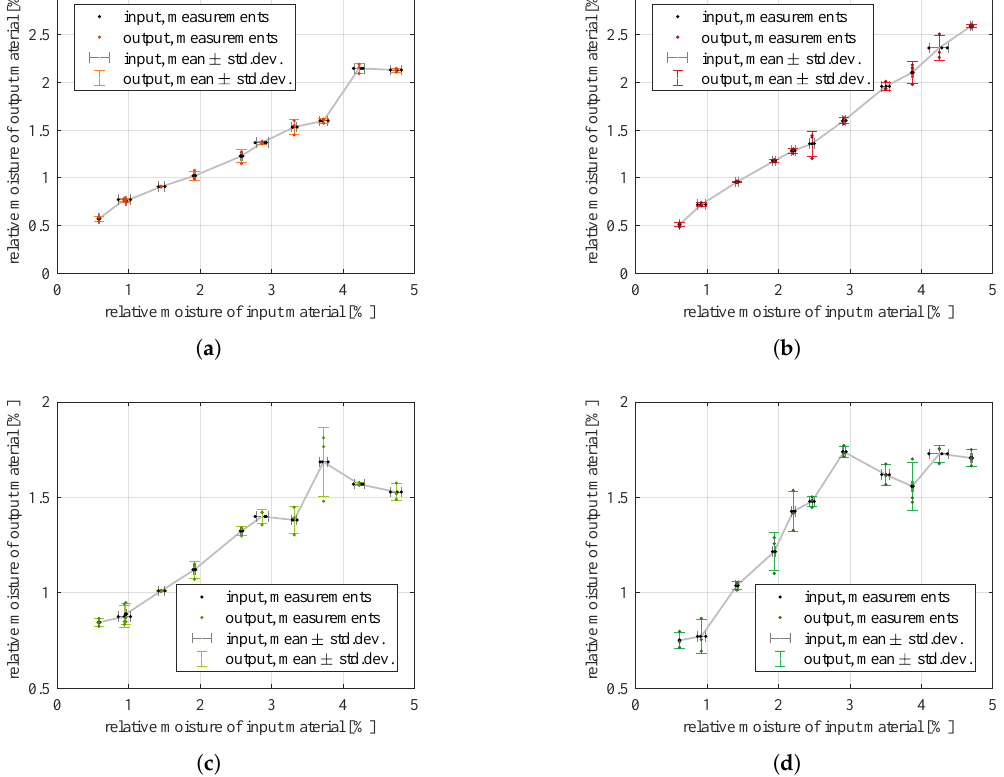
Figure 7. Measured moisture of both classification products related to moisture of input material, separately for different throughputs of the screw feeder: ( a ) lower product, 50% of nominal throughput; ( b ) lower product, 100% of nominal throughput; ( c ) upper product, 50% of nominal throughput; ( d ) upper product, 100% of nominal throughput. Points indicate three measurement attempts for each quantity in each experiment, error bars extend to ± 1 × sample standard deviation of the three measurements, cross-sections of horizontal and vertical error bars mark the averages of the three measurements. The fitted lines are plotted in Figure 8 together with their 95% prediction intervals.